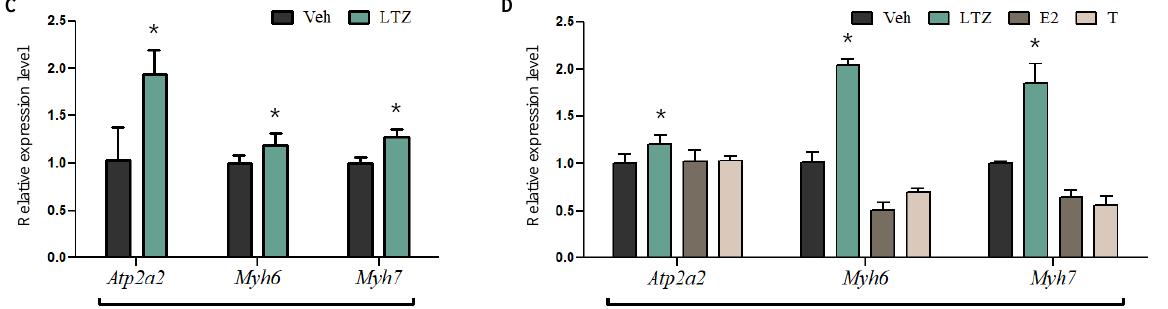
Figure 2. Letrozole induces hypertrophic change in the left ventricle (LV) in female rats. ( A ) The hearts of rats were examined via haematoxylin and eosin stain (H&E) to examine whether cardiac structural remodeling was developed when exposed to LTZ. Scale bar = 30 µ m. Area of cytoplasm and nuclei were measured quantitatively using Image J software. ( B ) The protein levels of representative heart failure markers were determined by Western blotting with LV tissues. Beta actin was used as internal control. ( C ) mRNA levels of representative physio-functional genes were determined using quantitative RT-PCR, with LV tissues. mRPLP0 was used as internal control. ( D ) mRNA levels of representative physio-functional genes were determined using quantitative RT-PCR, with H9c2 cells. These cells were exposed to fatty acids (Palmitic acid 330 µ M, Oleic acid 660 µ